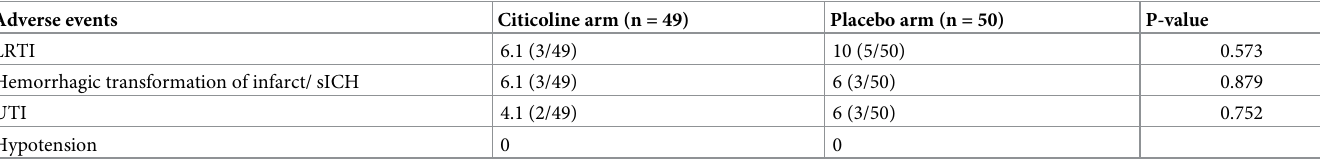
Citicoline and placebo groups. Shift analysis done for the mRS scores between the Citicoline and placebo groups was also not significant (Fig 2). Adverse events were found to be equally prevalent in both groups with no statistically sig- nificant difference between the same. All adverse events are mentioned in Table 3. Table 3. Adverse